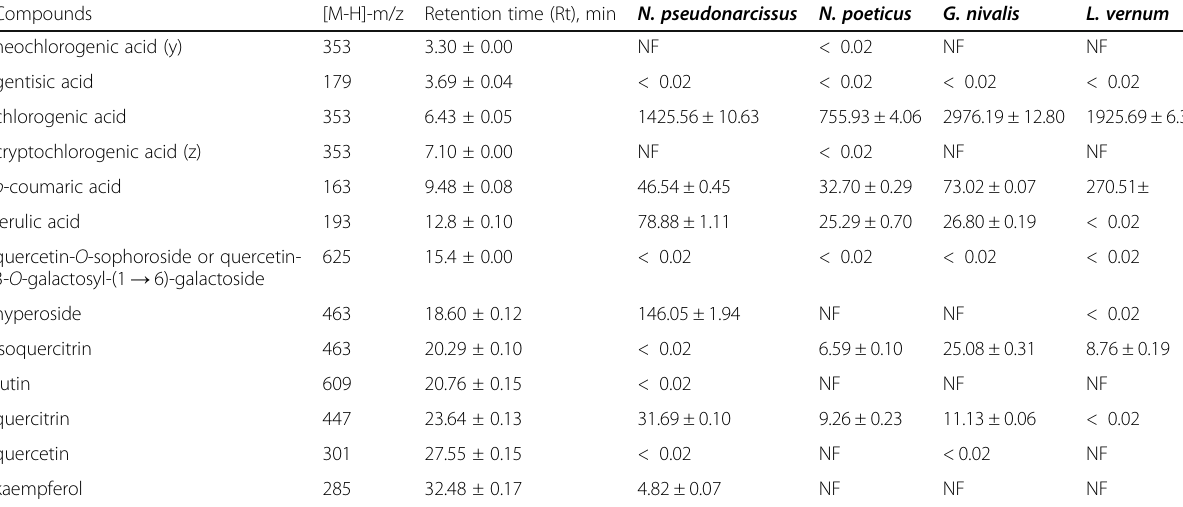
Table 1 The polyphenolic compounds analyzed by HPLC-MS ( μ g/g plant material)